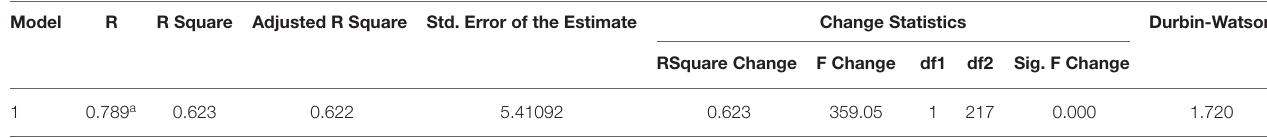
TABLE 3 | Predicting sedentary tendency among Mbororo Nomads. Model R R Square Adjusted R Square Std. Error of the Estimate